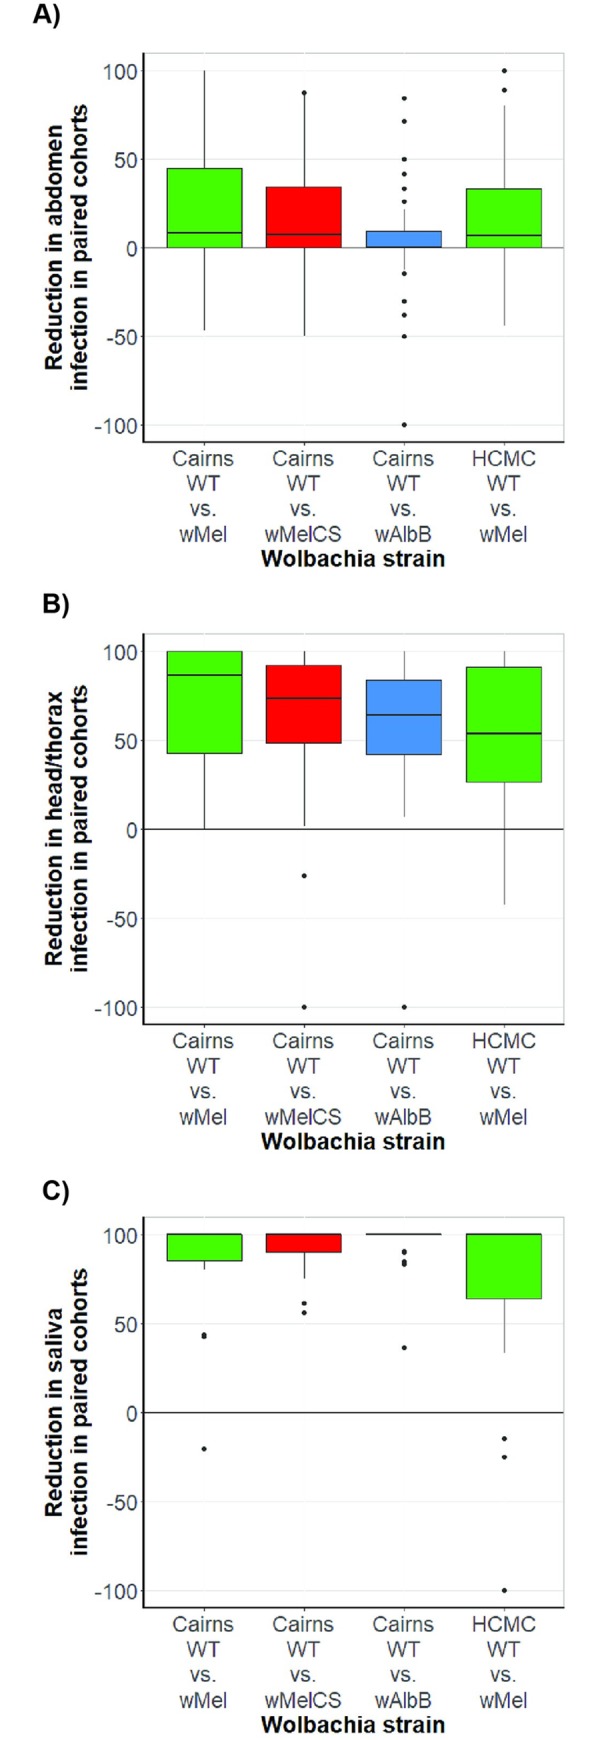
Wolbachia-mediated percentage change in infection prevalence of mosquitoes in the wMel, wAlbB and wMelCS strains on the Cairns and HCM genetic backgrounds.The boxplot depicts the percentage change (medians and interquartile range) in DENV infection prevalence in abdomen, head/thorax, or saliva, between paired WT and Wolbachia-infected mosquito cohorts. The y-axis represents the percentage change in infection prevalence, ranging from 100 (meaning all mosquitoes containing Wolbachia are DENV-uninfected, and any number of WT mosquitoes are DENV-infected), through 0 (reflecting equal DENV infection prevalence between the paired cohorts), to -100 (reflecting all wildtype mosquitoes being DENV-uninfected, and any number of Wolbachia-infected mosquitoes are infected with DENV). Data is stratified by host Wolbachia infection and mosquito genetic background. A) abdomen infection; B) head/thorax infection; C) saliva infection, measured by inoculation of saliva into naïve mosquitoes.